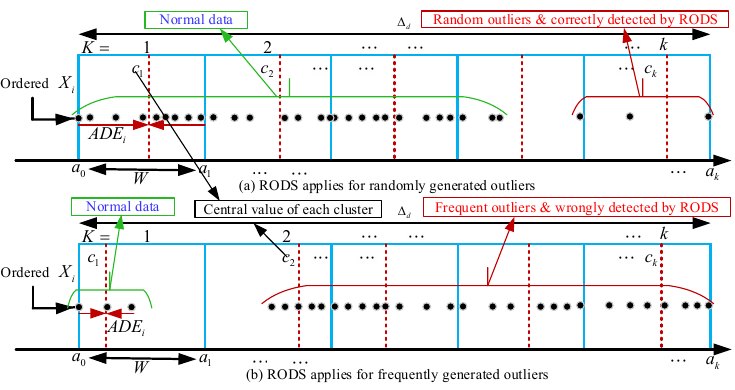
Figure 4. Error-aware data clustering technique by considering noisy data stream. ( a ) Recursive outlier detection and smoothing (RODS) applies for detecting random outliers; ( b ) RODS applies for detecting frequent